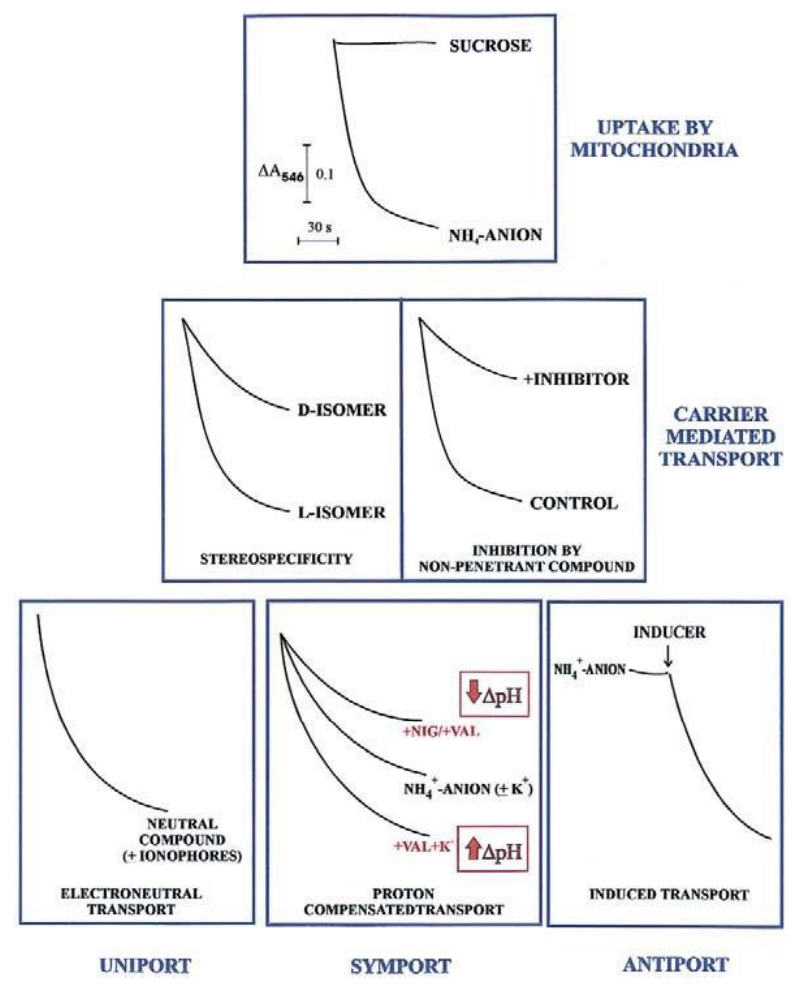
Figure 1. Mitochondrial swelling in transport studies, from Passarella et al. [9]. With permission from Elsevier, 2021.